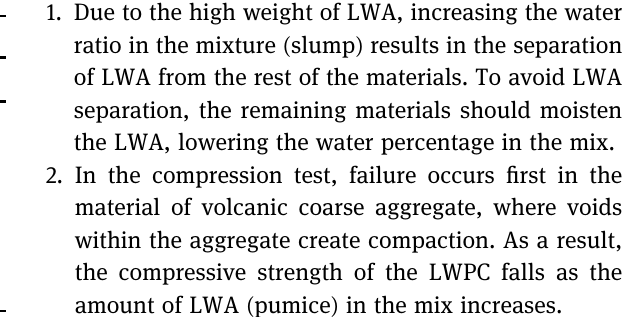
Table 9: Density loss ( kg/m 3 ) of mixes with temperature